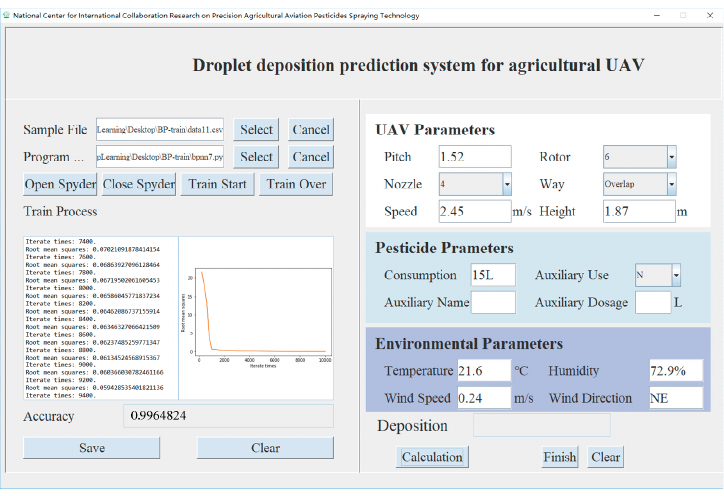
Figure 16. Software interface for droplet deposition prediction system for agricultural UAV.